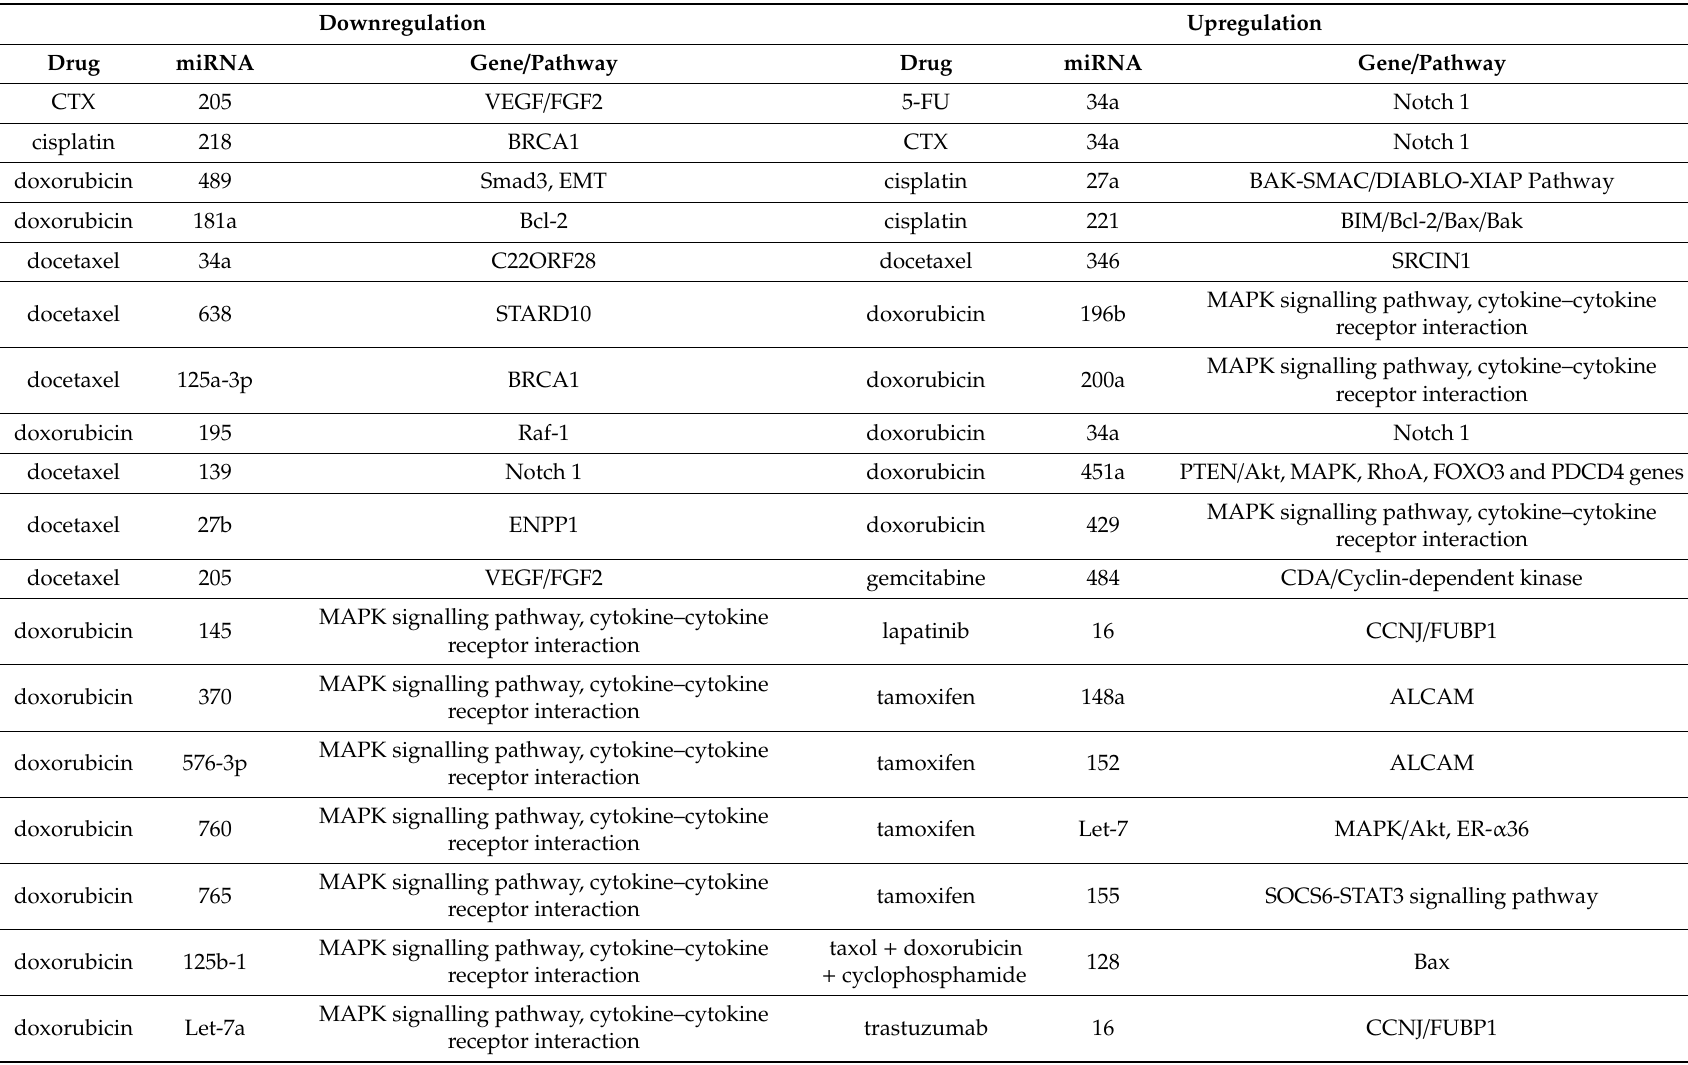
Table 3. Pathways involved in